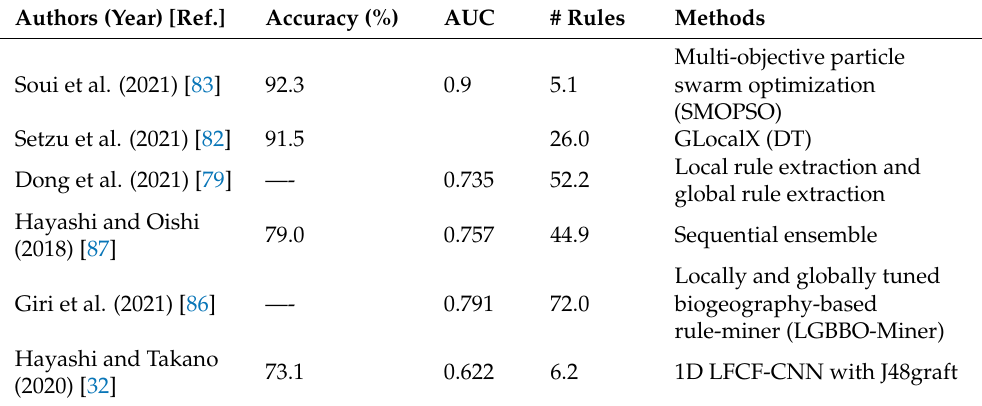
Table 12. Performance of rule extraction methods and rule-based classifiers for the German (categori- cal) dataset.